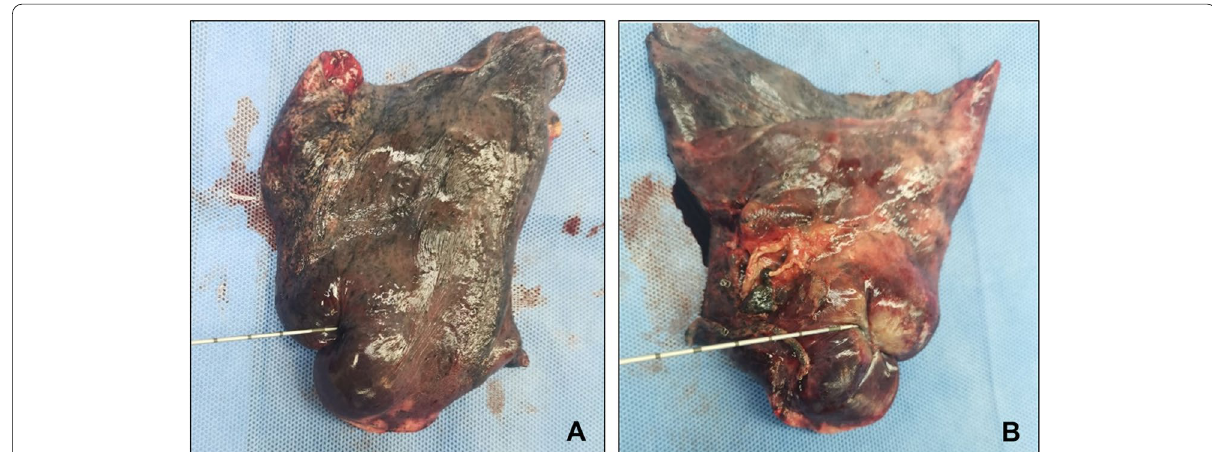
Fig. 1 Representative picture of intraoperative core needle biopsy. A Needle puncture performed at the point of maximum diameter of the lesion. B Resection of the lesion after biopsy to confirm an appropriate